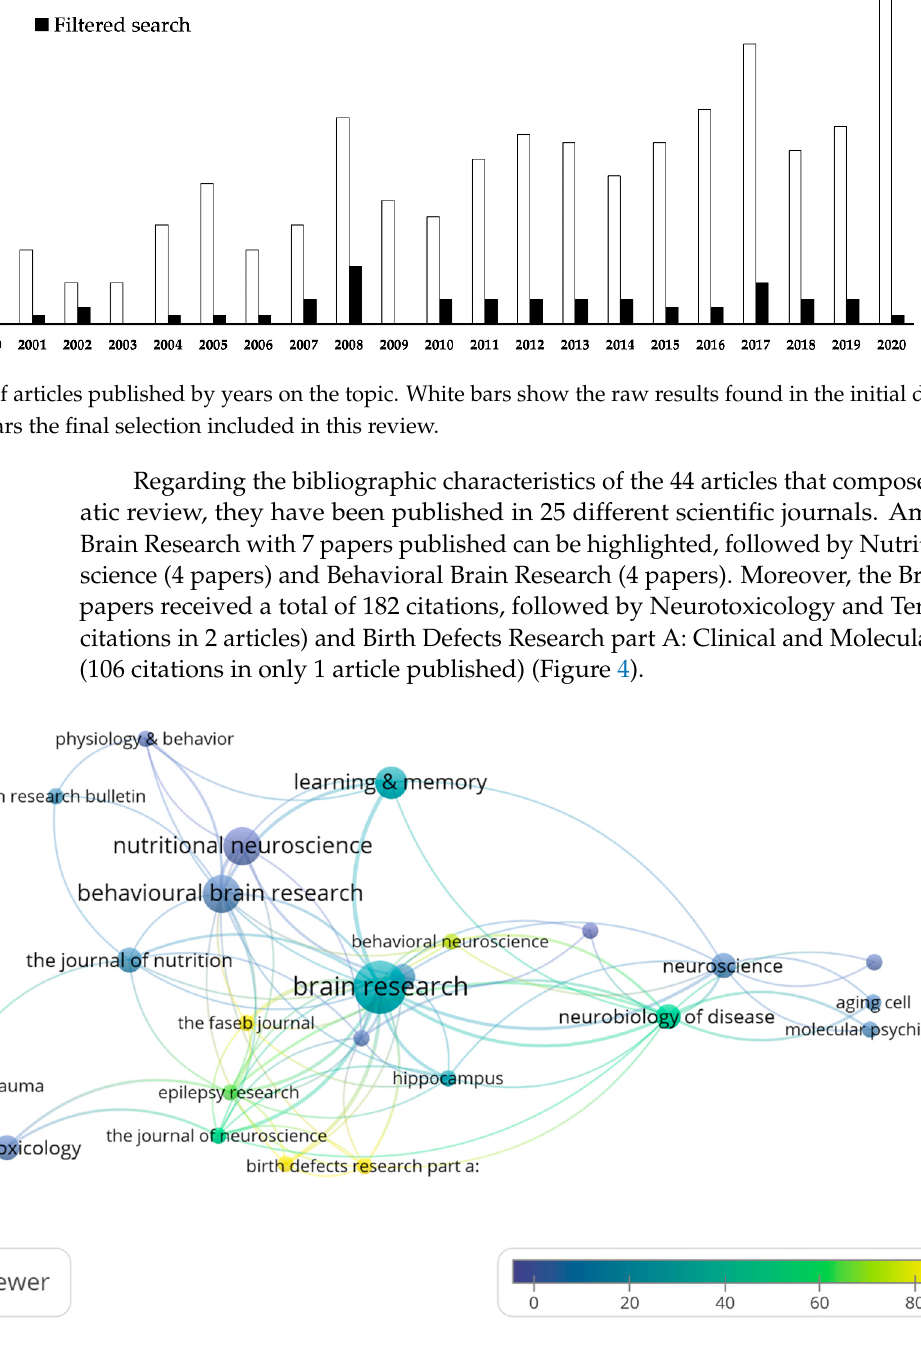
Figure 4. Network data map of the scientific journals in which the articles have been published. Point size represents the number of published articles. The colors represent the number of citations of each article. The lines indicated the links between journals based on crosscitations.